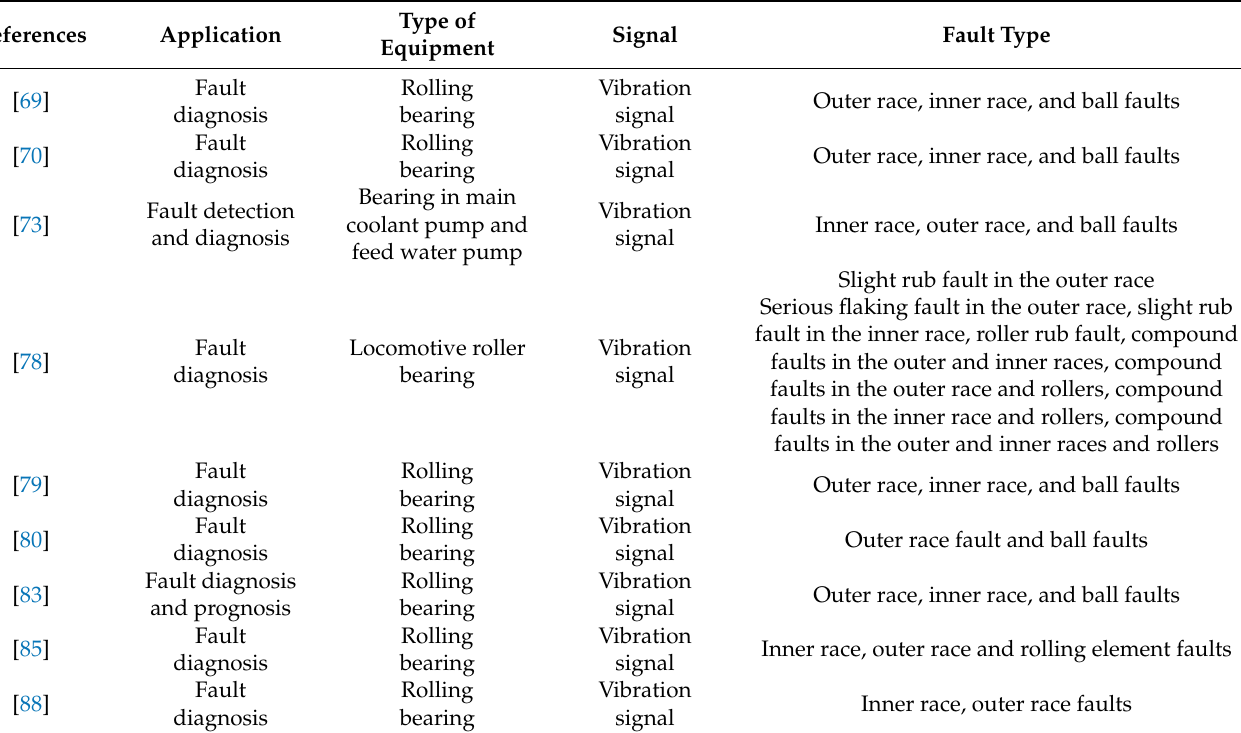
Table 9. Bearing condition monitoring using empirical model